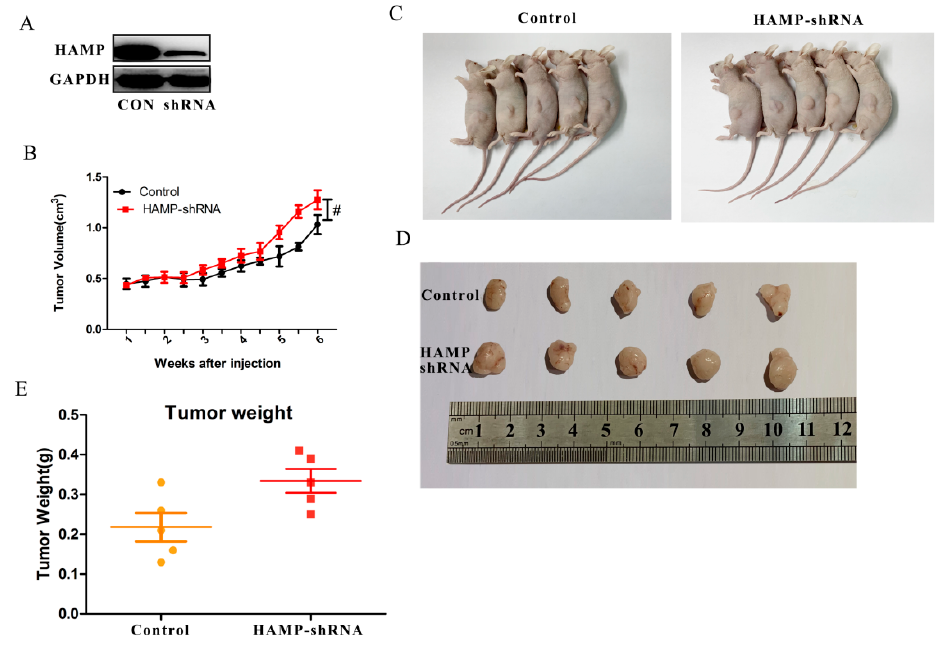
Figure 4. HAMP affects hepatocellular carcinoma proliferation in vivo. SMMC-7721 cells transfected with control or shRNA were injected s.c. in BALB/c-nu mice. ( A ) HAMP expression in tumors. ( B ) Tumor volume, measured every other day. ( C , D ) Tumor volumes changes in control and shRNA mice. ( E ) Tumor weight changes in control and shRNA mice. ( n = 5). # p < 0.05.